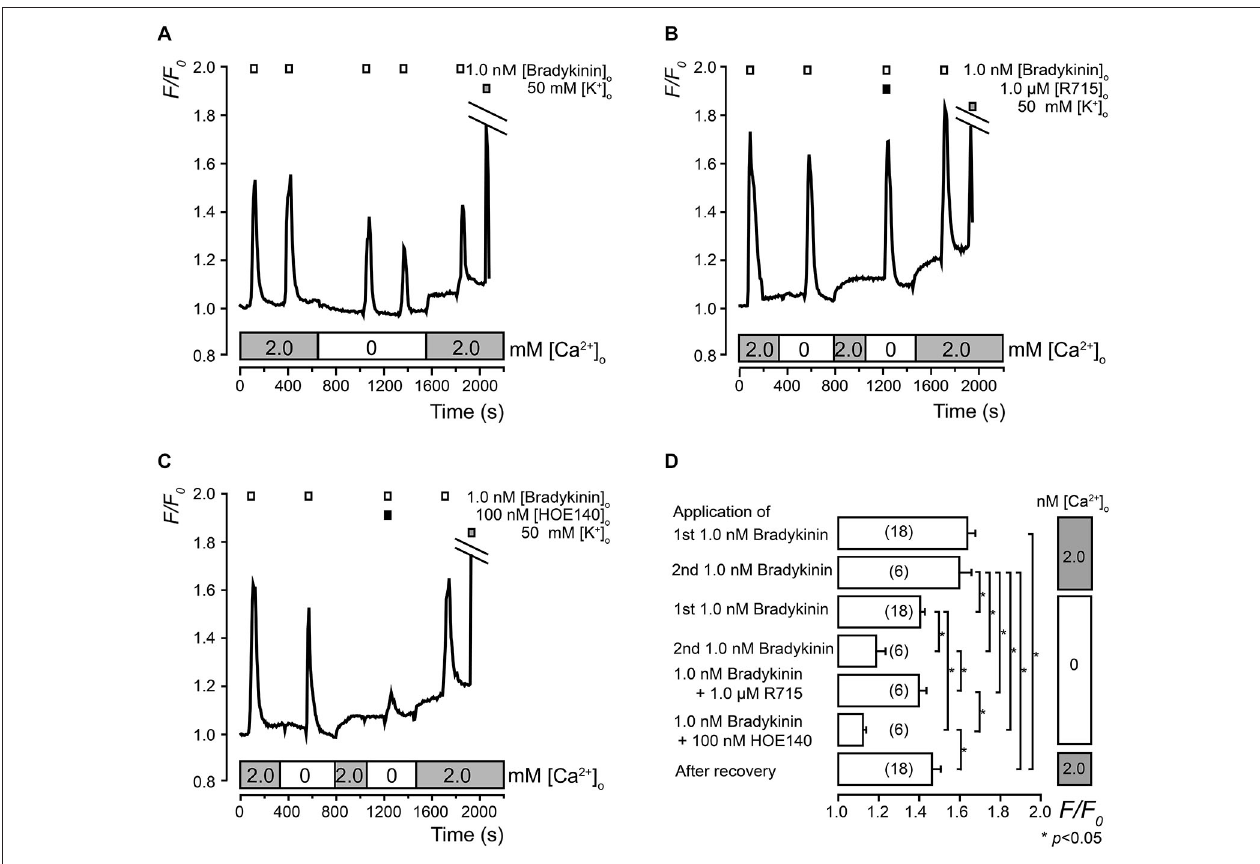
[Ca 2 + ] i increases during the first (upper column) and second (second upper column) application of 1.0 nM of BK with external Ca 2 + (2.0 mM) (gray boxes on the right side). The mean values of the increase in [Ca 2 + ] i following the first (third upper column) and second (fourth upper column) application of 1.0 nM of BK in the absence of external Ca 2 + as well as the application of 1.0 nM of BK with 1.0 µ M of R715 (fifth upper column) and 100 nM of HOE140 (sixth upper column) in the absence of external Ca 2 + (white boxes on the right side) are shown. Each column denotes the mean ± S.E. of the indicated (in parentheses) number of experiments. The statistical significance between the columns (shown by solid lines) is indicated by asterisks: * p <